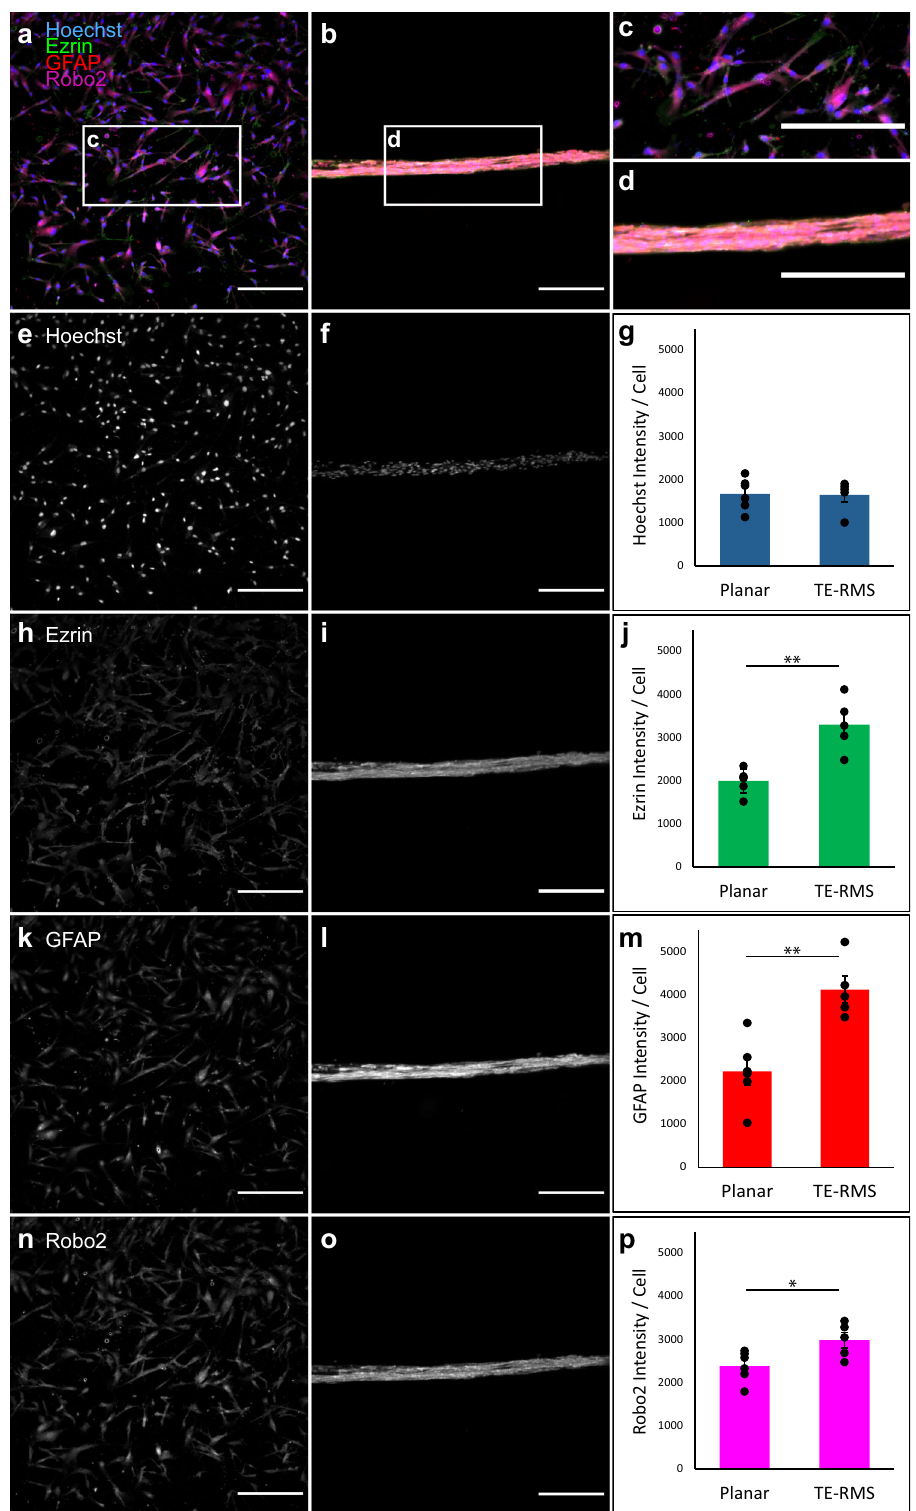
Fig. 5 TE-RMSs fabricated from adult human gingiva-derived astrocytes are enriched in GFAP, Ezrin, and Robo2 relative to planar sister cultures. Astrocytes derived from adult human gingiva stem cells were passaged, split, and either plated in a planar collagen matrix or used for TE-RMS fabrication. Cell nuclei were labeled with Hoechst stain, and cells were immunostained for GFAP, Ezrin, and Robo2. Representative wide views of merged fl uorescent channels are provided for planar sister cultures ( a ) and TE-RMS ( b ), with call-out boxes providing magni fi ed views of planar ( c ) and TE-RMS ( d ) organization, morphology, and relative protein. Maximum contrast white-on-black single-channel images along with quanti fi cation of normalized intensities are provided for Hoechst ( e – g ), Ezrin ( h – j ), GFAP ( k – m ), and Robo2 ( n – p ). Values are displayed as mean±SEM. Means were compared by Student ’ s t -test. * p <0.05, ** p <0.01. Scale bars: 250